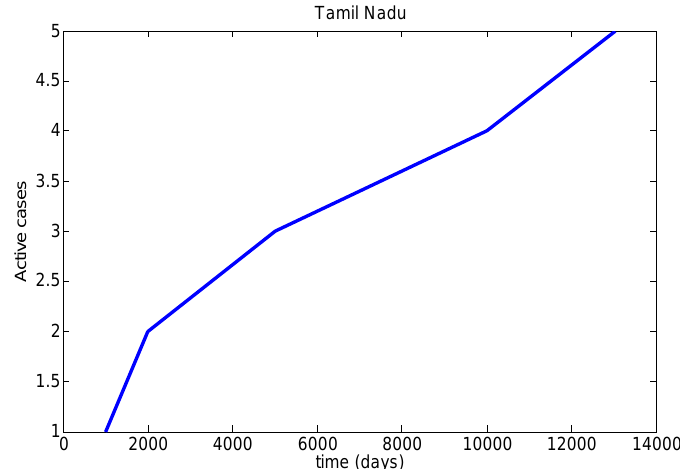
Figure 10. Active cases of Tamil Nadu from real life